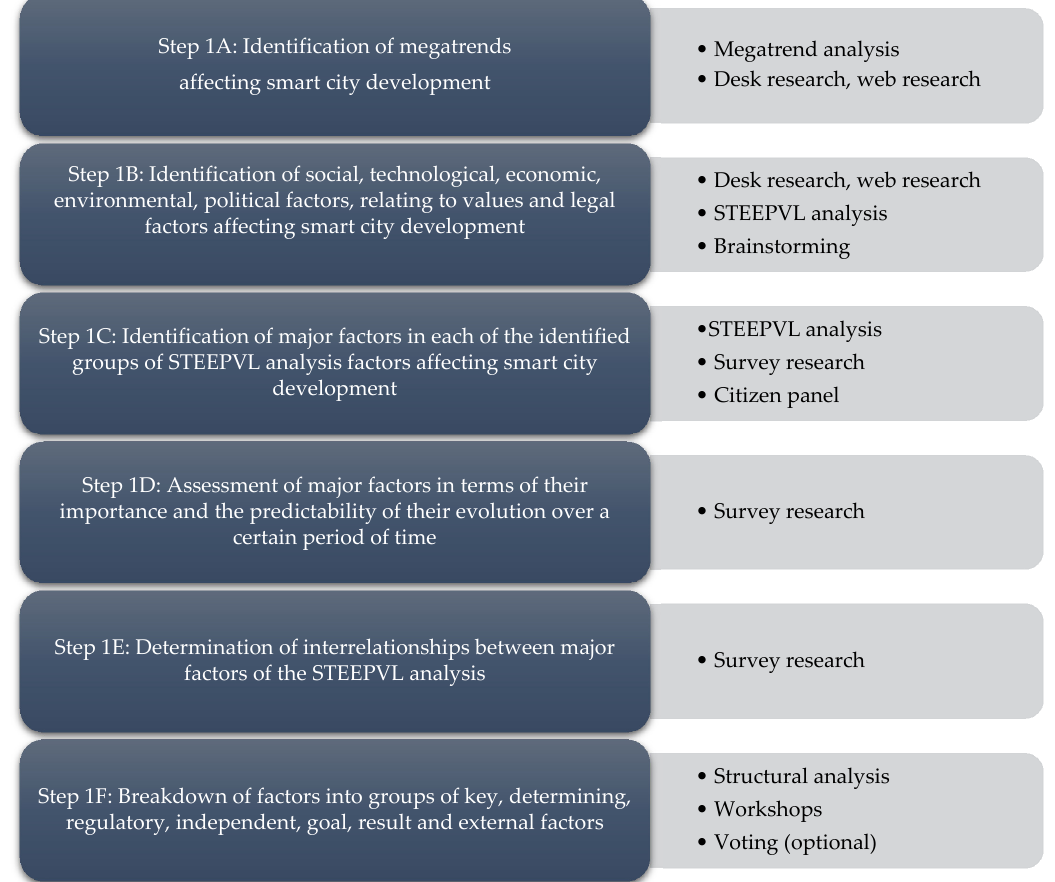
Figure 4. Operationalisation scheme for Stage 1 of the research process.